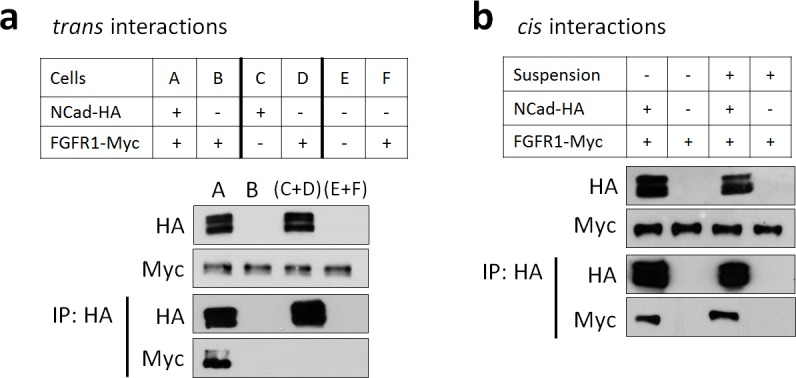
FGFR1-NCad binding does not occur in trans, between cells but occurs in cis, within cells.(a) FGFR1-NCad binding does not occur in trans, between cells. Cells were transfected with FGFR1-Myc and NCad-HA together (A), NCad-HA and vector (C), or FGFR1-Myc and vector (D and F). The transfected cells were removed from the dish, mixed as shown, and re-plated to allow cell-cell contact. One day later the cells were lysed and immunoprecipitated with anti-HA. Lysates and immunoprecipitates were analyzed by Western blotting. FGFR1-Myc co-precipitated with NCad-HA when co-expressed (A) but not when binding could only occur between cells (C+D). (b) FGFR1-NCad binding occurs in cis, within cells. Cells were transfected with FGFR1-Myc and NCad-HA or vector, then left in contact or placed in suspension to prevent cell-cell interaction. One day later the cells were lysed and immunoprecipitated with anti-HA. Lysates and immunoprecipitates were analyzed by Western blotting. FGFR1-Myc co-precipitated with NCad-HA whether or not cell-cell contact was permitted. All experiments were repeated three times with similar results.